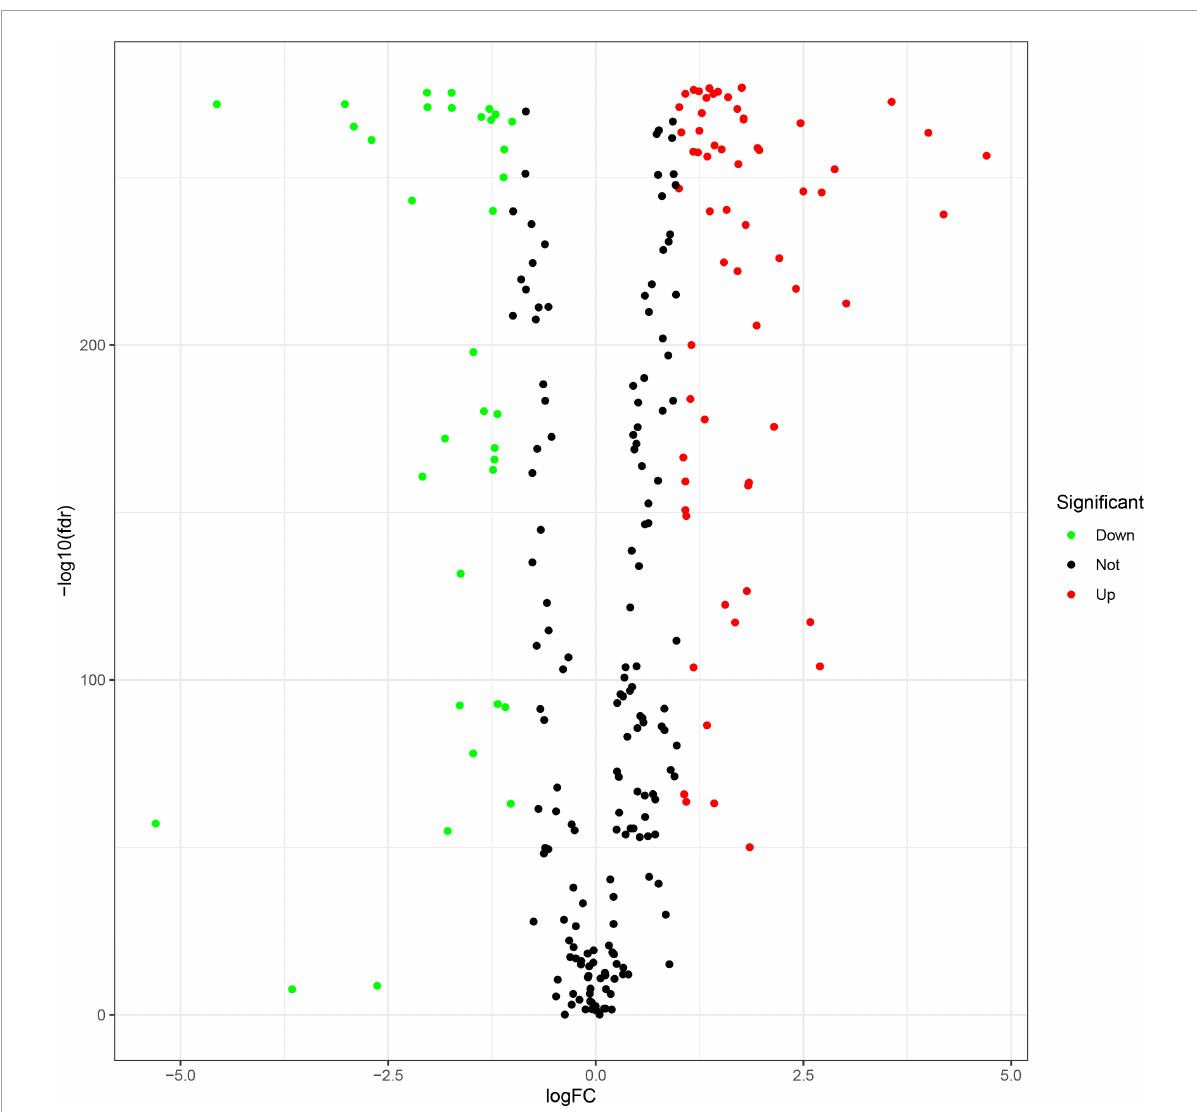
FIGURE3 Volcano plot of differential gene expression analysis between tumor and normal